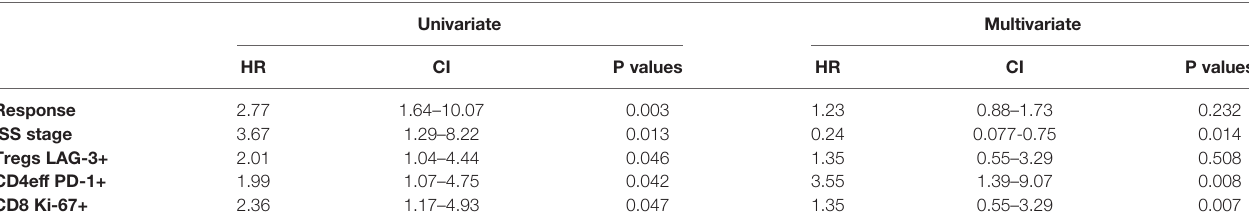
Figure 3 ). Detailed analysis of marker expression on T cell